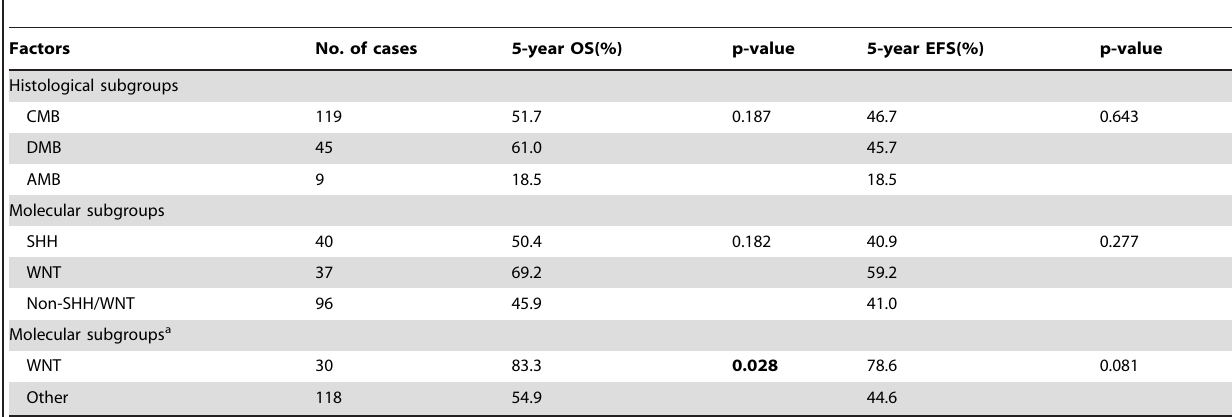
Table 3. Univariate analysis of histological and molecular subgroups for OS and EFS in medulloblastoma patients (n=173).